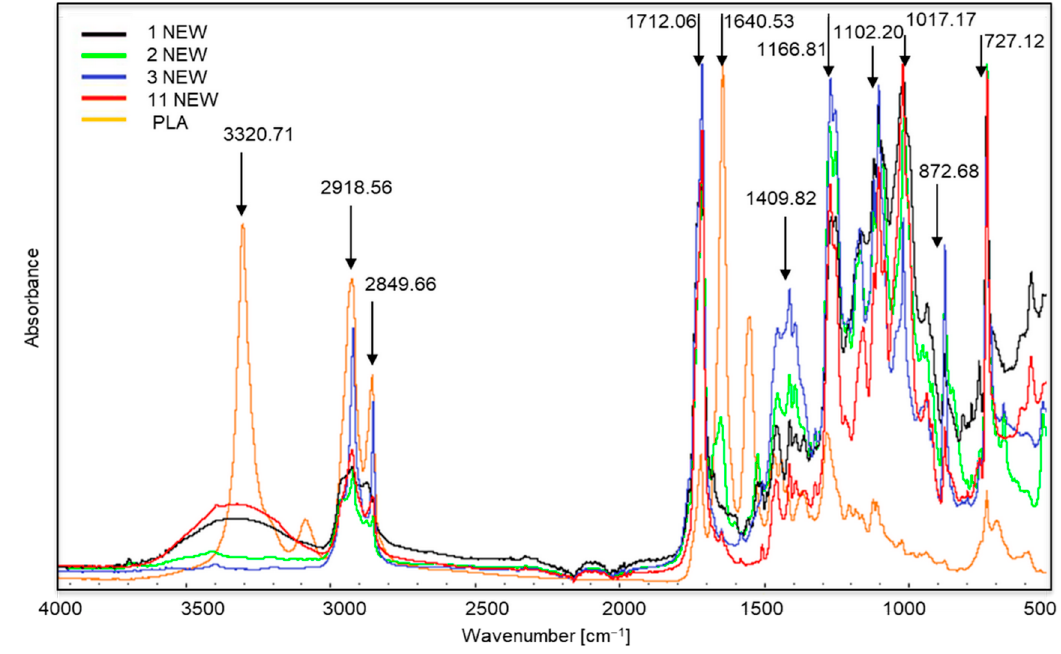
Figure 2. Spectra of new samples 1, 2, 3 and 11, which were decomposed in the composting process. The polylactide (PLA) spectrum was added for comparison.